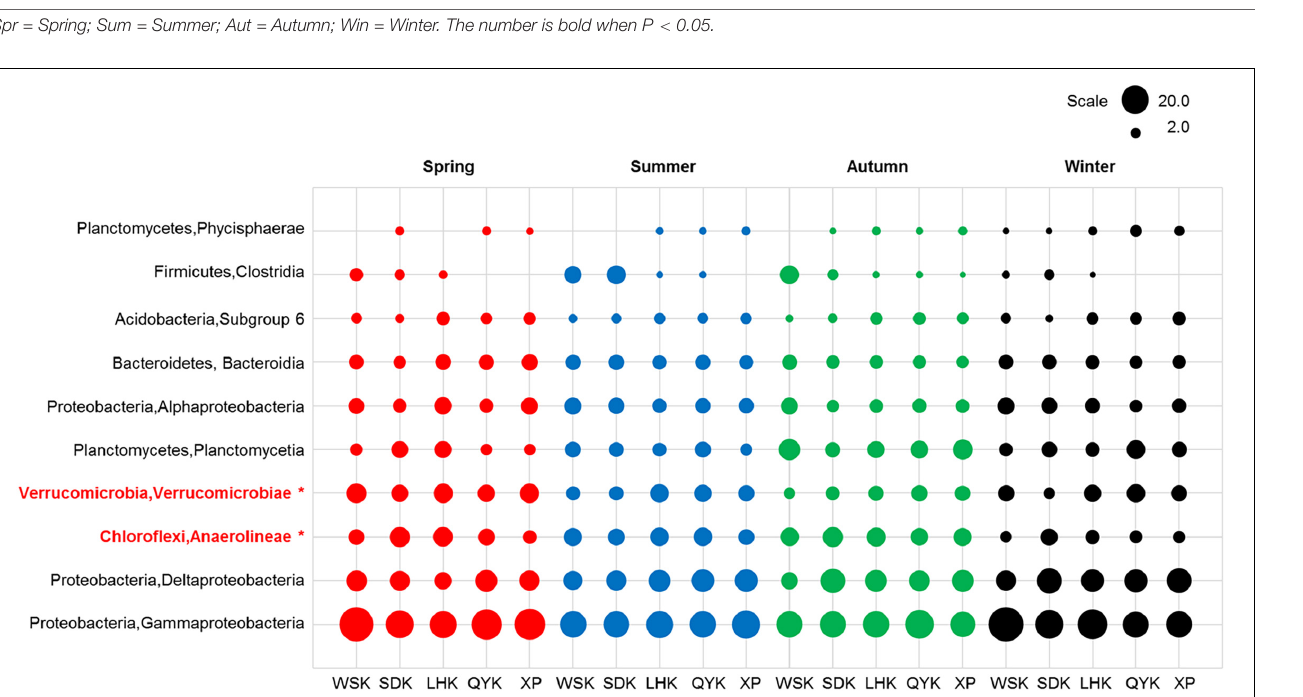
FIGURE 4 | Relative abundances of dominant bacterial classes in sediments from different sampling sites among various seasons (Red = Spring, Blue = Summer, Green = Autumn, Black = Winter). Asterisks represent a significant difference among the seasons according to Kruskal-Wallis H-test from STAMP pipeline (Kruskal-Wallis H-test, P <